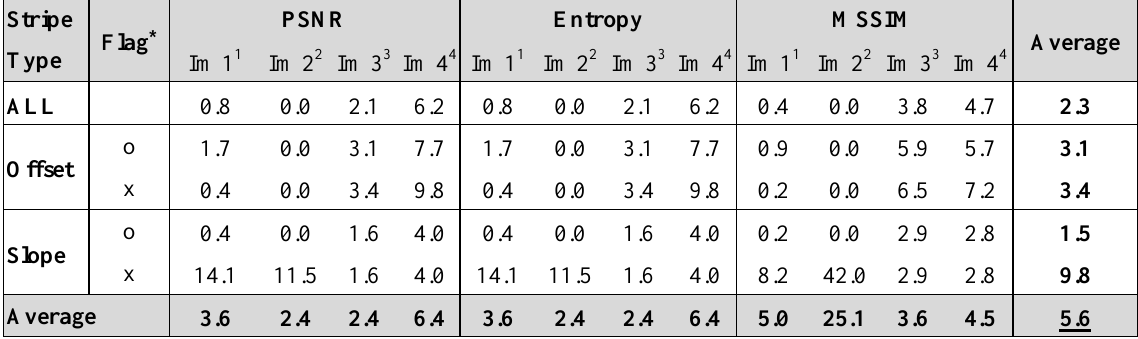
Table 2. Average stripe magnitude impact on this approach for all destriped images [%].